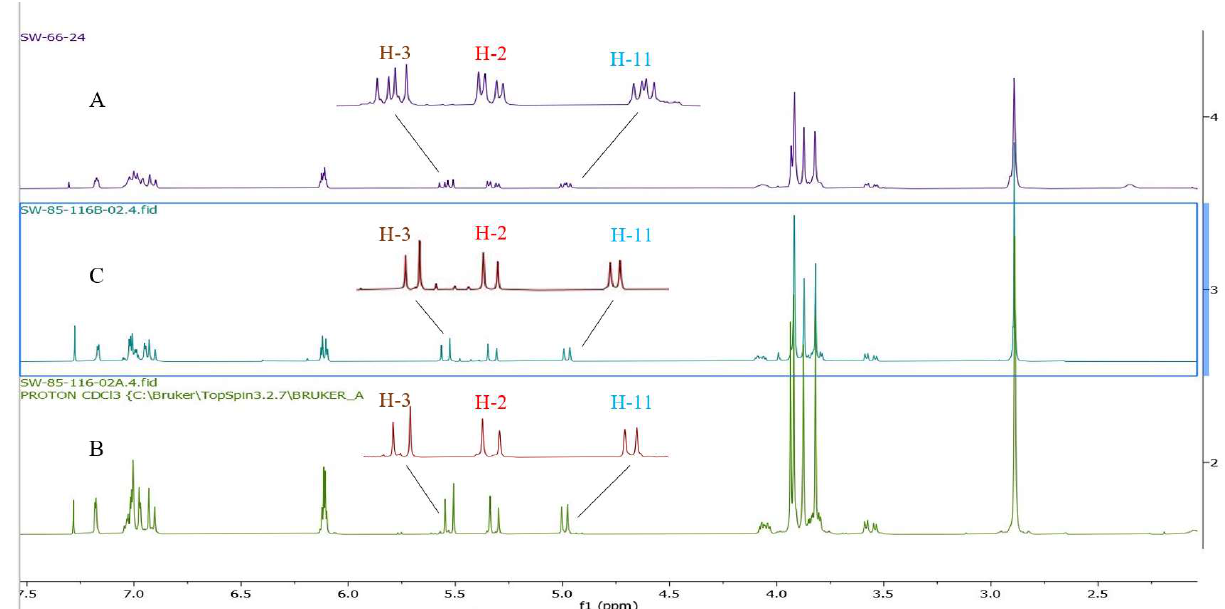
Figure 8. 1 H NMR spectra of 3- O -dimethylcarbamoyl-5,7,20- O -trimethylsilybin. ( A ) 1 H NMR spectrum of diastereomeric mixture of 3- O -dimethylcarbamoyl-5,7,20- O -trimethylsilybin ( 6 ). ( B ) 1 H NMR spectrum of optical pure 3- O -dimethylcarbamoyl-5,7,20- O -trimethylsilybin A ( 6A ). ( C ) 1 H NMR spectrum of optical pure 3- O -dimethylcarbamoyl-5,7,20- O -trimethylsilybin B ( 6B ).